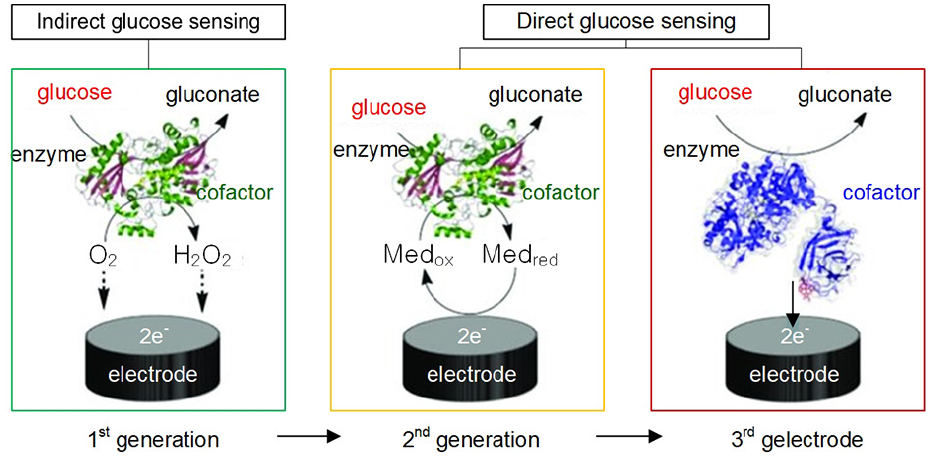
Figure 3. First-, second-, and third-generation glucose biosensors.